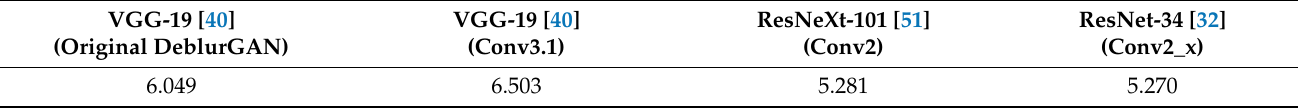
Table 7. Comparison of finger-vein recognition error (EER) of restored images in SDU-DB according to the perceptual loss based on the various CNN models and layers (unit: %).